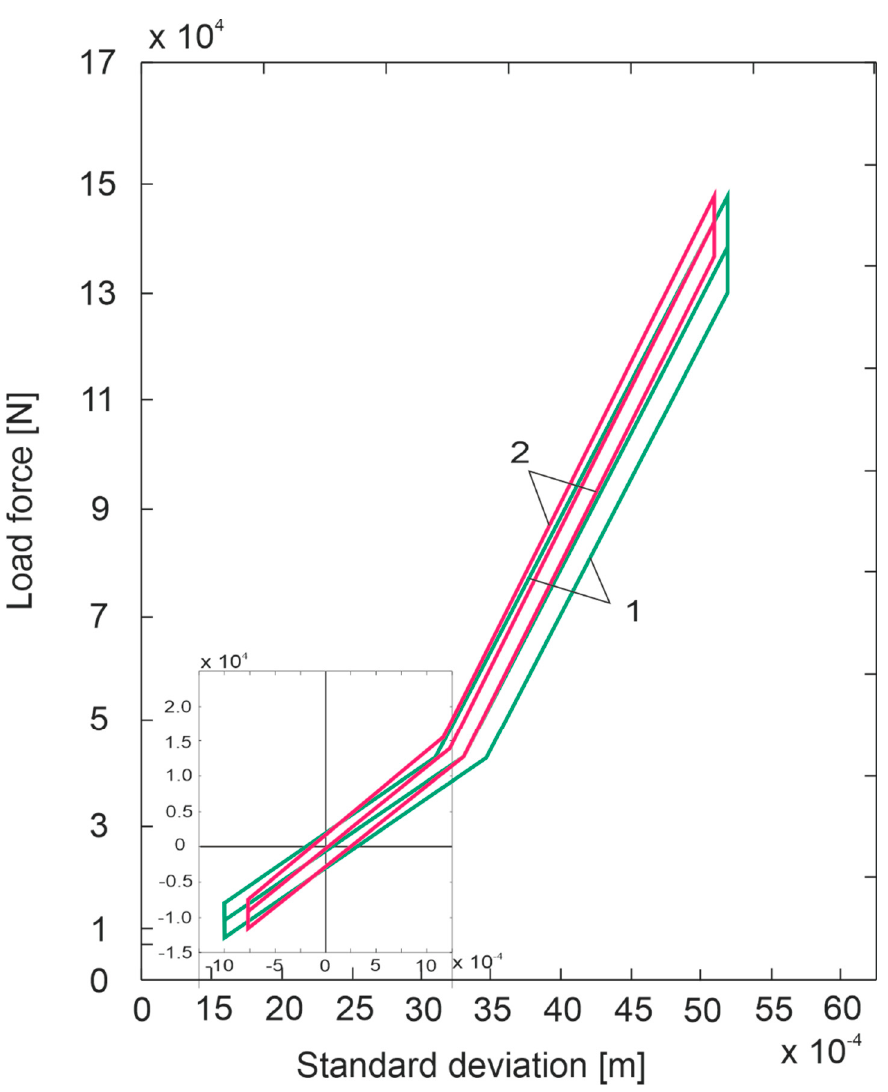
Figure 6. Summary of the hysteresis loops of the left (1) and right (2) rails. On the basis of the experimental results, the following analytical description of the track forces on the wheel was considered to be the most appropriate: